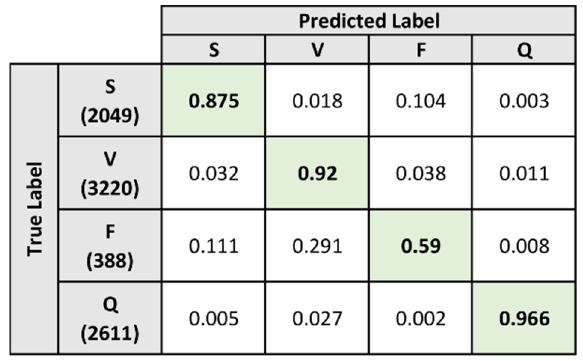
Figure 14. Normalized confusion matrix for Model B on test dataset. Table 6. Performance metrics for Model B on test dataset.